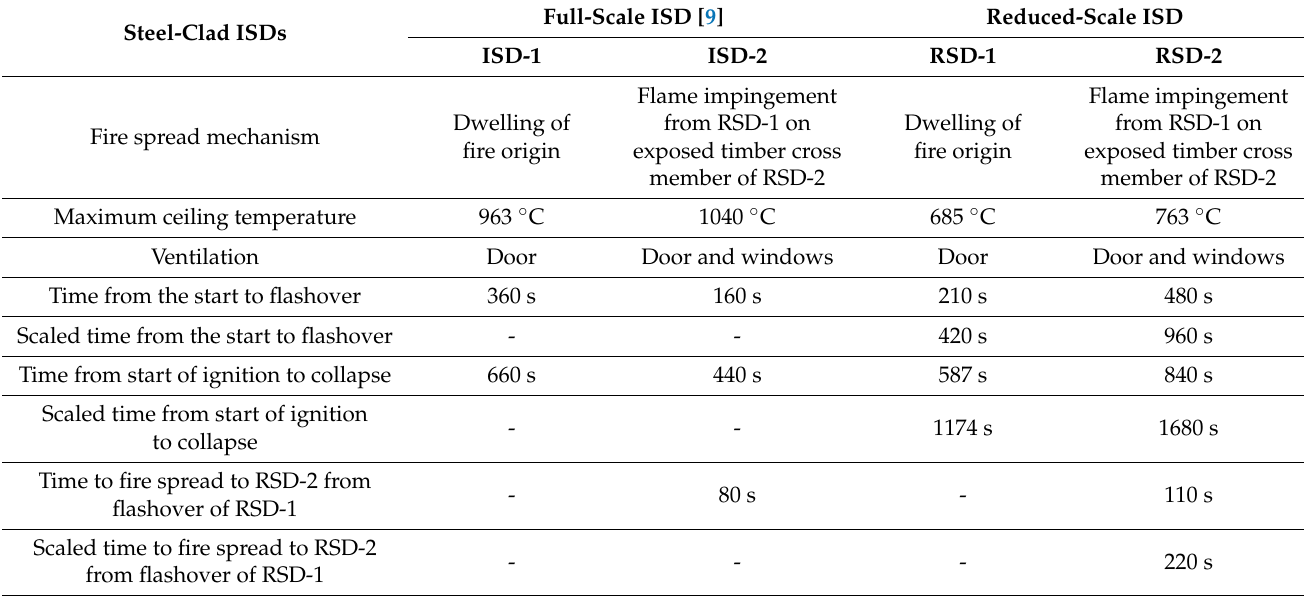
Table 4. Comparative results from longitudinal fire spread between two steel-clad